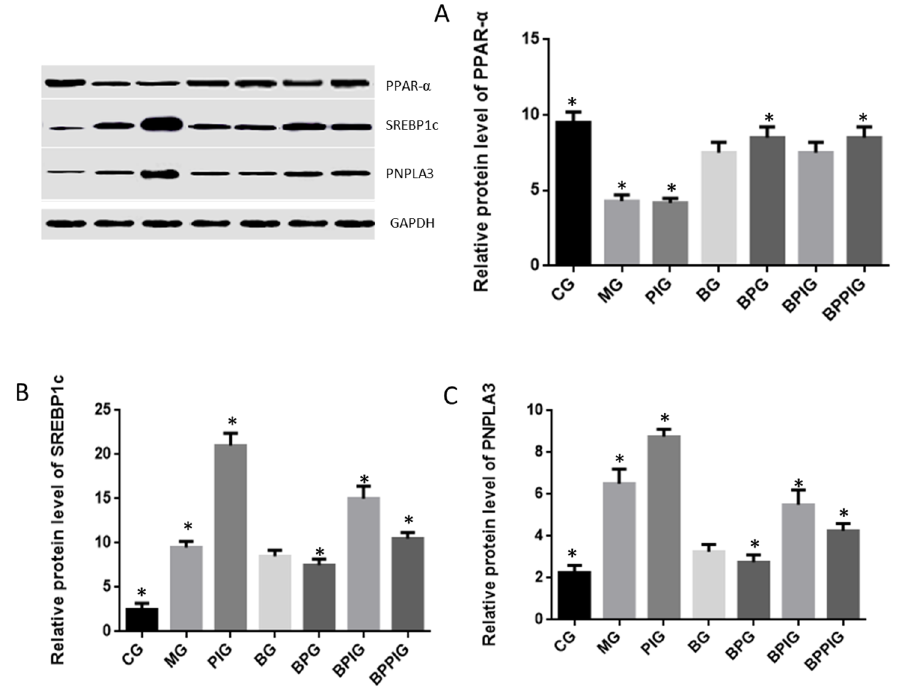
Figure 11. Western blot analysis of the protein levels of SREBP ‐ 1c/PNPLA ‐ 3 pathway and its interacting molecules. ( A ) relative protein level of PPAR ‐ α ; ( B ) relative protein level of SREBP ‐ 1c; ( C ) relative protein level of PNPLA3. Eight liver samples were analyzed in each group. All data are presented as mean value ± S.D. * p < 0.05 via a blueberry juice group BG.